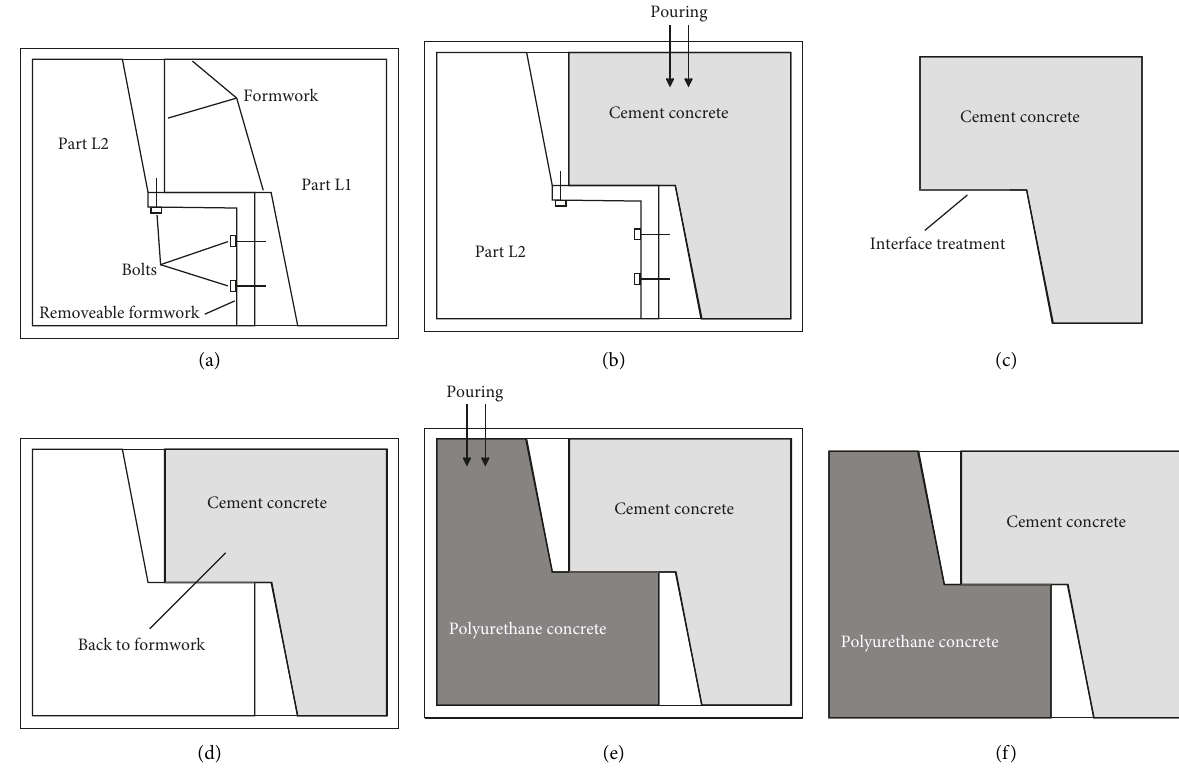
Figure 11: Specimen preparation